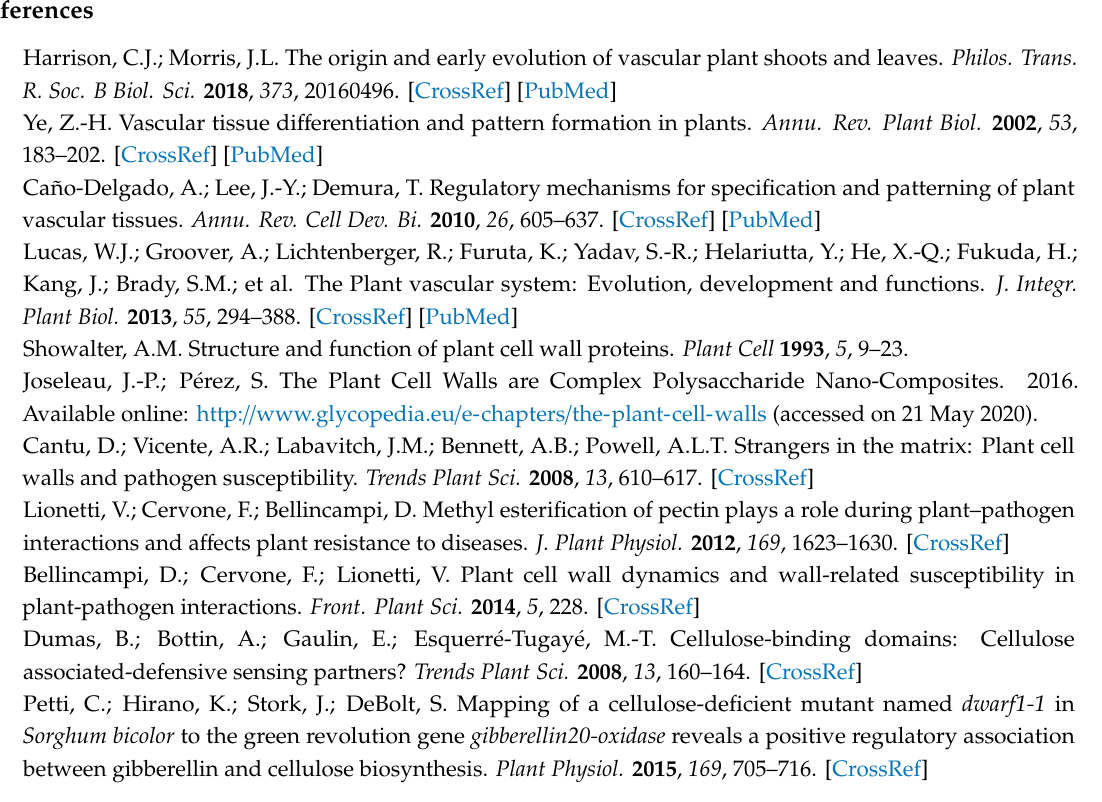
Figure S1. Construction of pEGAD- BnMYB43-1 . Figure S2. Construction of pFGC5941M- BnMYB43I . Figure S3. Identification of MYB43I transgenic lines and comparison of BnMYB43 expression level between WT and BnMYB43I transgenic plants. Figure S4. Sequence analysis of the BnMYB43 gene family from B. napus . Figure S5. The plant phenotype of BnMYB43I transgenic plants. Table S1. Primers used in this study. Table S2. Cellulose, lignin and pectin compositions measurement of the BnMYB43I transgenic plants. Table S3. Lignin monomer compositions measurement of the BnMYB43I transgenic